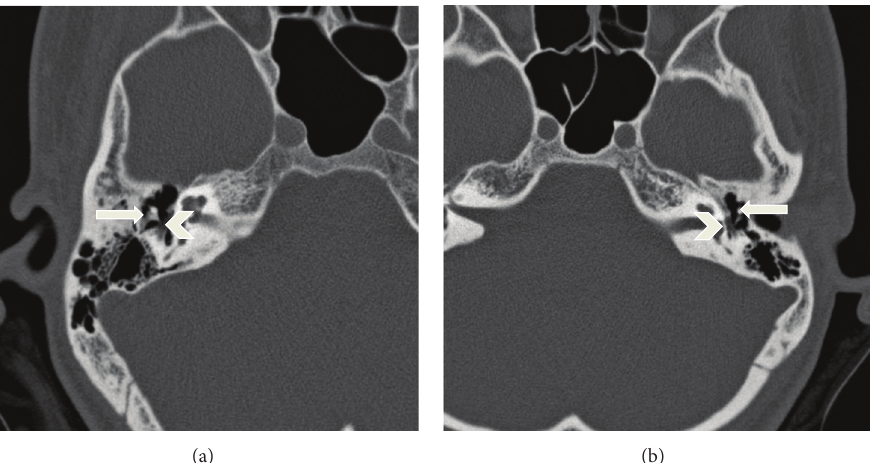
Figure 2: Right (a) and left (b) axial CT scan of the temporal bone showing the bilateral absence of the stapes (arrow), the abnormal position of the facial nerve (arrowhead), normal pneumatization of the mastoid air cells, and normal inner ear